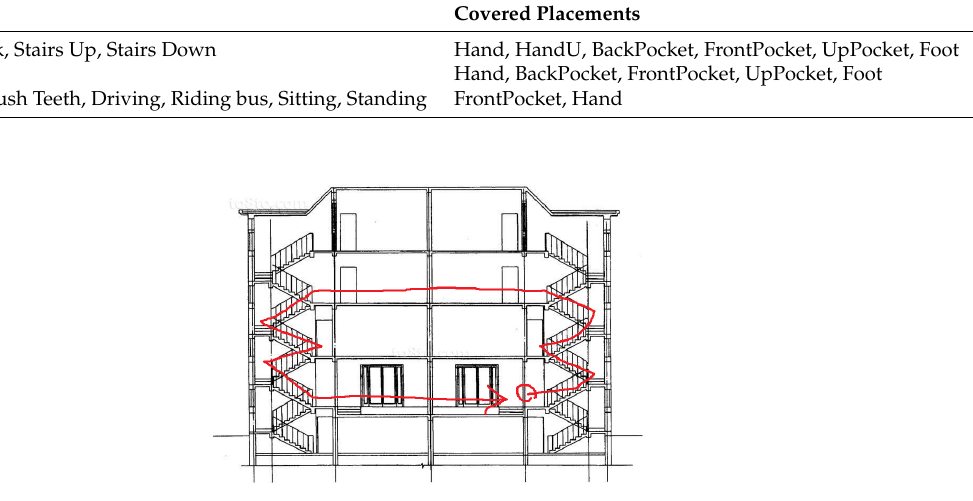
Figure 3. Designed indoor trajectory in data